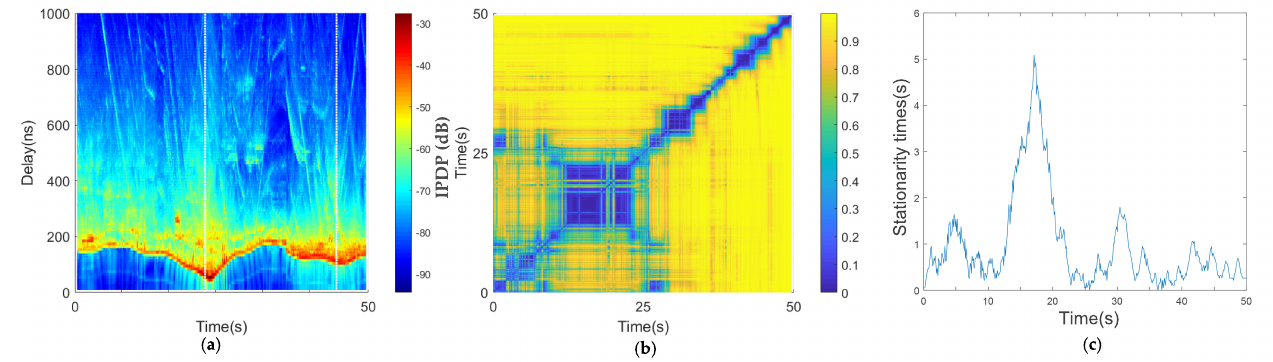
Figure 8. Results of car-following, medium-speed scenario: ( a ) average PDPs, ( b ) temporal PDP correlation coefficient, and ( c ) stationarity time estimate.